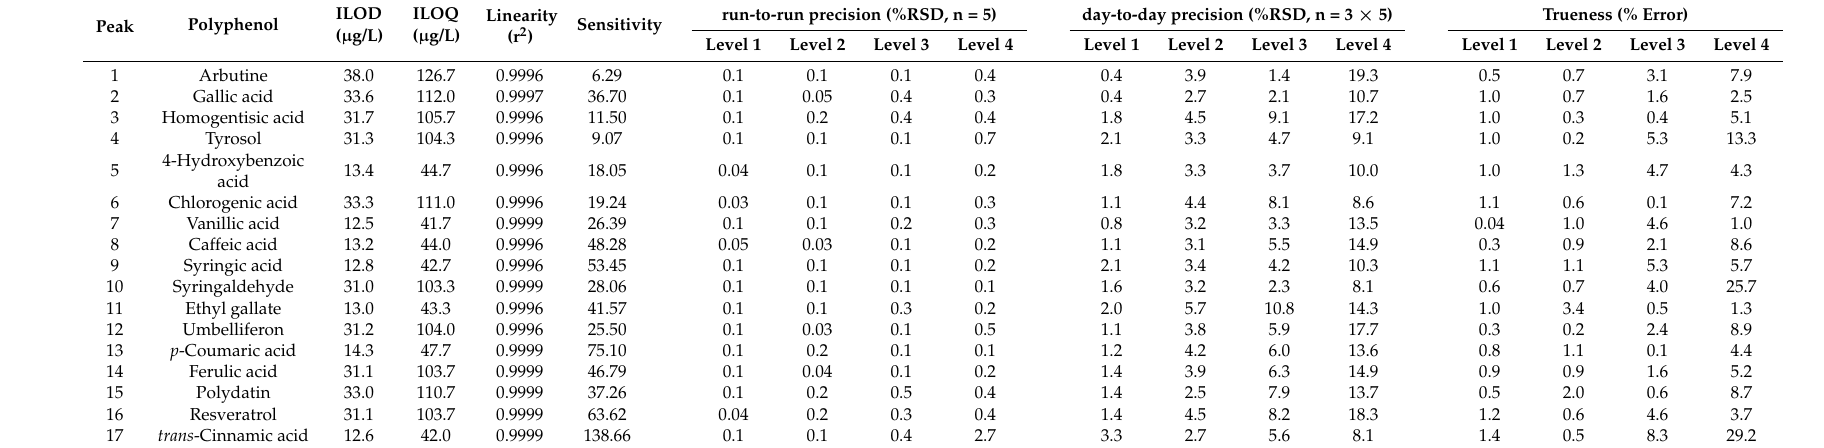
Table 2. Instrumental quality parameters of the proposed HPLC-UV